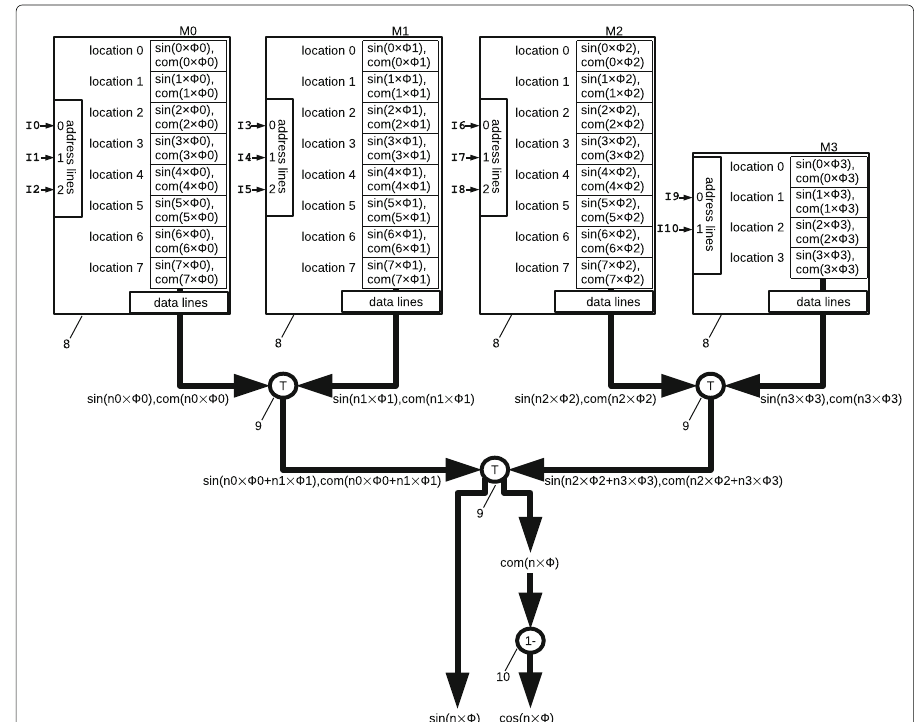
Fig. 4 Sine/cosine generator implemented with a sine/complement